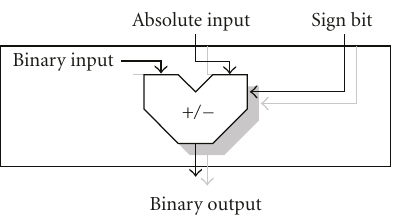
Figure 3: Single-digit one-bit sign accumulation component.